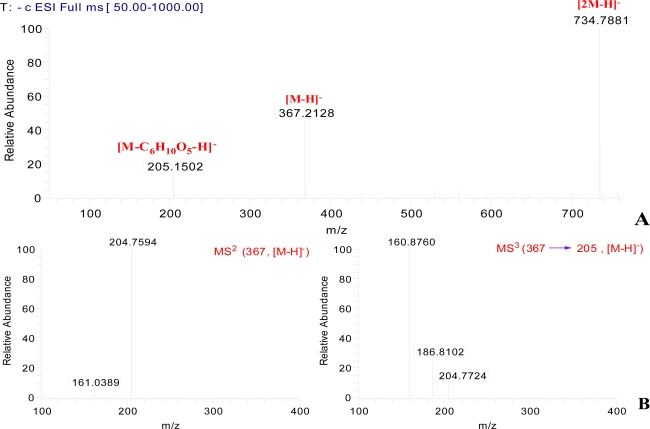
ESI-MS (A) and ESI-MSn (B) for compound 1 in negative mode.